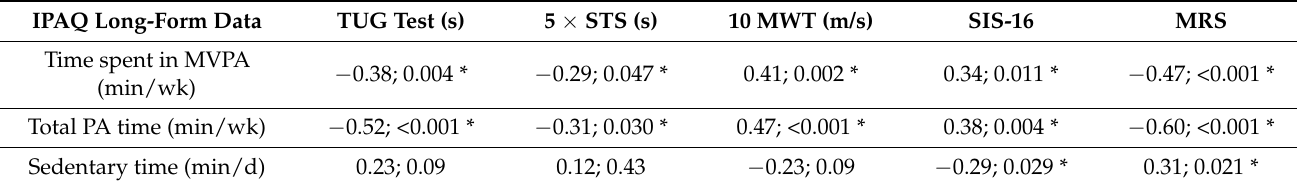
Table 4. Association between the IPAQ long-form and physical function.